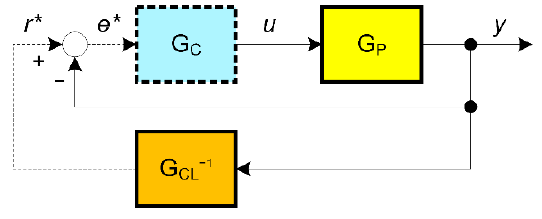
Figure 1. VRFT controller tuning principle.